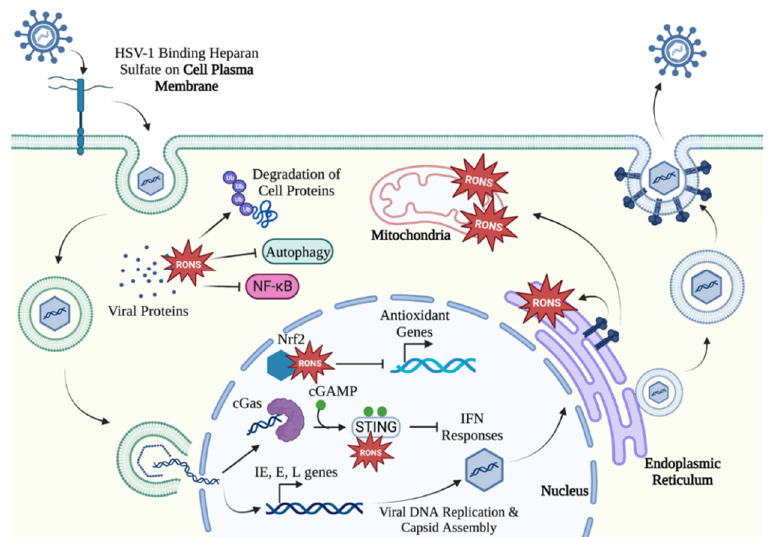
Figure 2. During infection of an epithelial cell, HSV-1 depends on the cell for endosome trafficking and its replication machinery. Due to this dependence, HSV-1 infection is invasive and must continuously avoid immune clearance from the cell. To overcome this, HSV-1 manipulates the cellular redox environment by upregulating oxidative stress responses to overwhelm the cell’s capacity for balancing redox, crafting an environment that promotes HSV-1 replication. This allows the virus to avoid sensing by immune receptors and the subsequent innate responses directed against